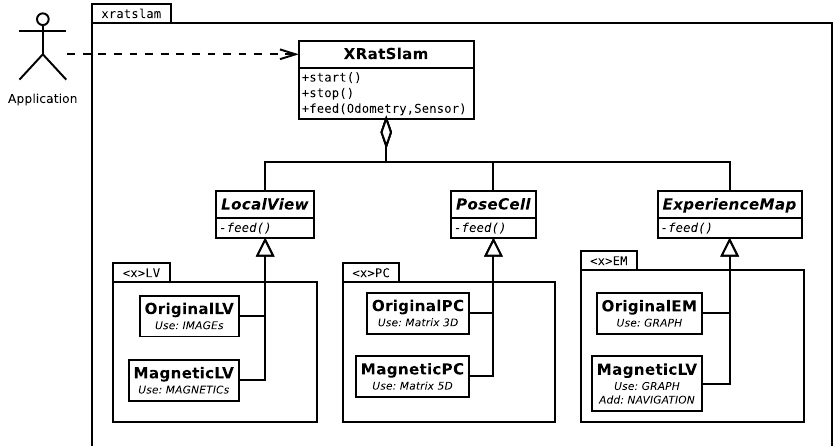
Figure 2. xRatSLAM main class diagram. Modules are designed as abstract classes, which different possible module implementations can easily overload. The diagram shows two implementation examples for the LocalView module: the original one uses visual sensors, and another uses magnetic sensors. Used symbols follow standard